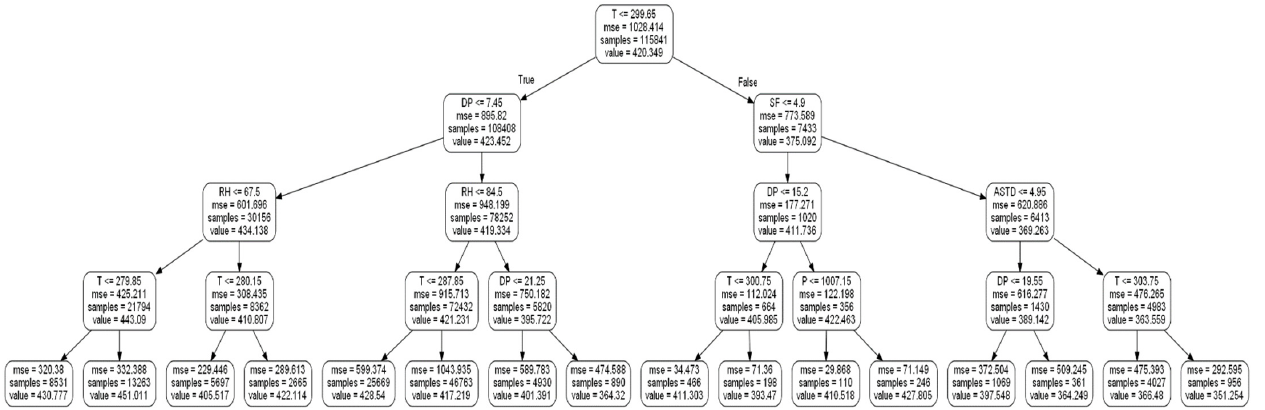
Figure 5. Decision Tree model for RSSI prediction. Each node depicts the split selection parameter, the resulted mean squared error (MSE) of the split, the number of samples included to the specific region and the mean RSSI value based on the samples of the region.